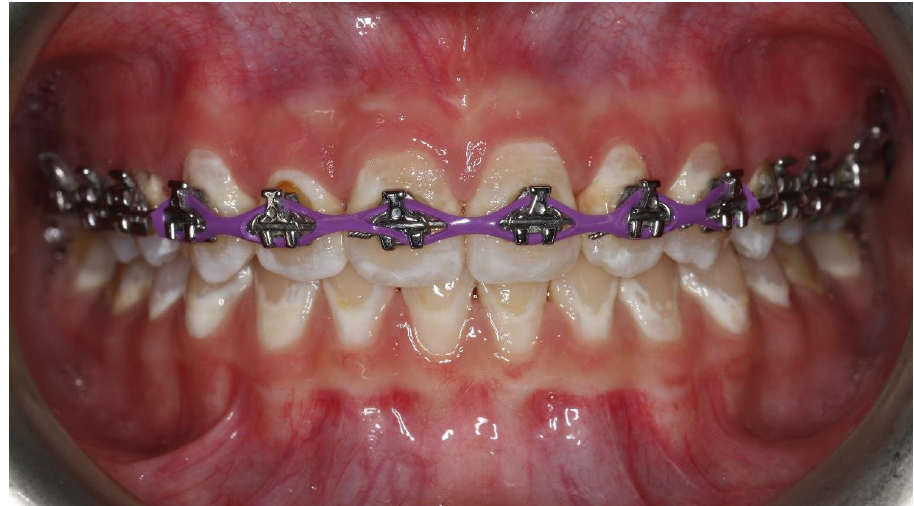
Figure 1. White spot lesions caused by insufficient oral hygiene during orthodontic treatment.